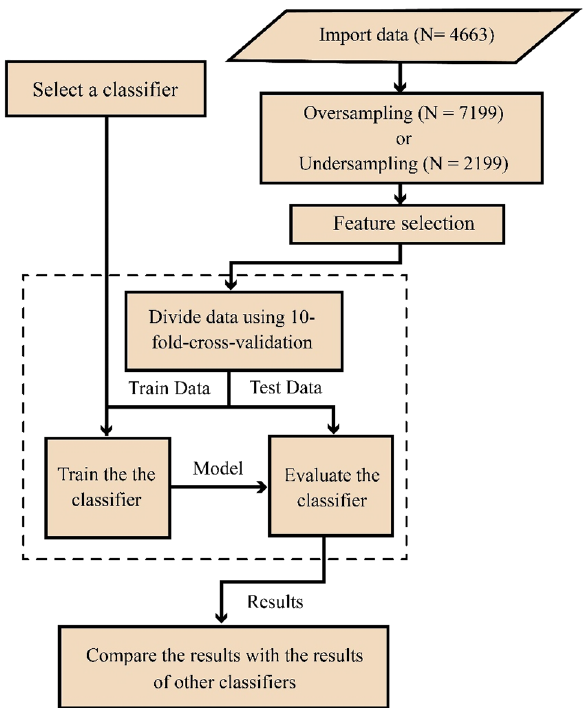
Figure 2. The flowchart of the methodology used in this